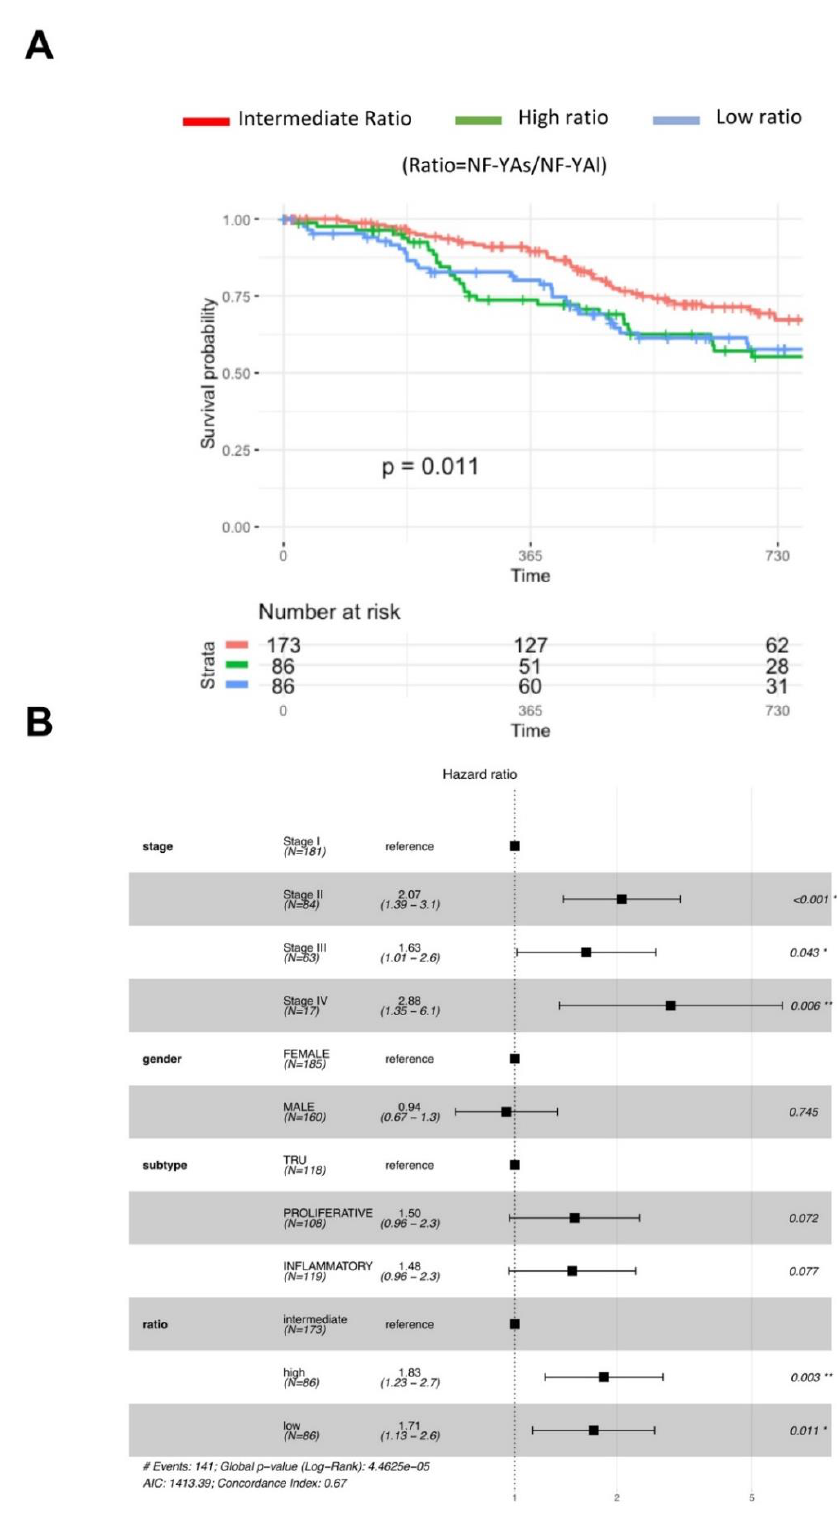
Figure 8. Clinical outcome of LUAD tumors with different NF-YAs/NF-YAl ratios. ( A ) Progression-free interval curves of survival probability of LUAD tumors with stratification according to quartiles of NF-YAs/NF-YAl ratios (intermediate, high, and low). ( B ) Hazard ratios of the three cohorts as above, according to stage (I–IV), gender, sub-type (Basal set as reference), and NF-YAs/NF-YAl ratios. p -values were calculated using a Cox proportional hazards regression analysis (See section 2.5).